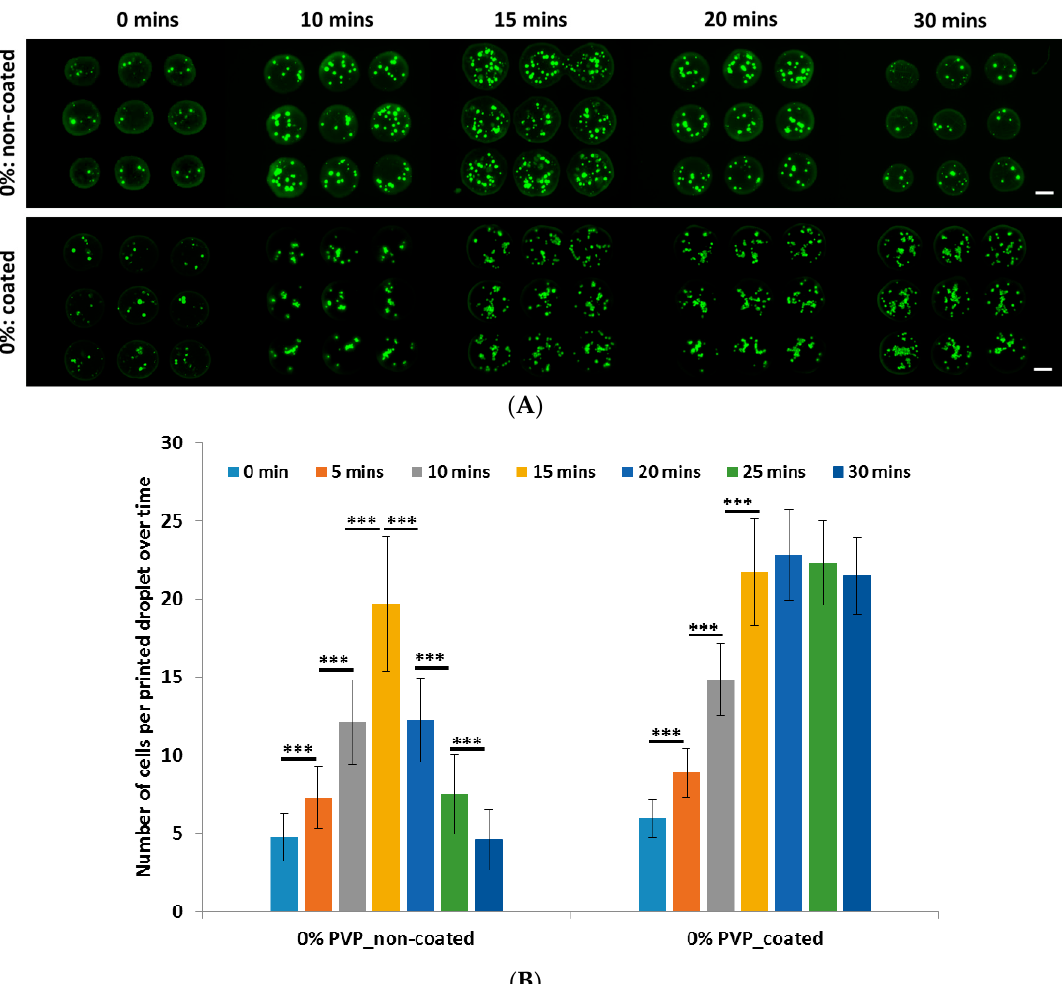
Figure 4. ( A ) Representative images of printed cells in non-coated and coated printing cartridges (constant cellular concentration of 1.0 mil cells/mL) at different time intervals (scale bar: 200 µm); ( B ) A graph showing the number of cells per printed droplet over time (mean ± SD). Significance levels are as follows: p < 0.005 (***), p < 0.05 (*).